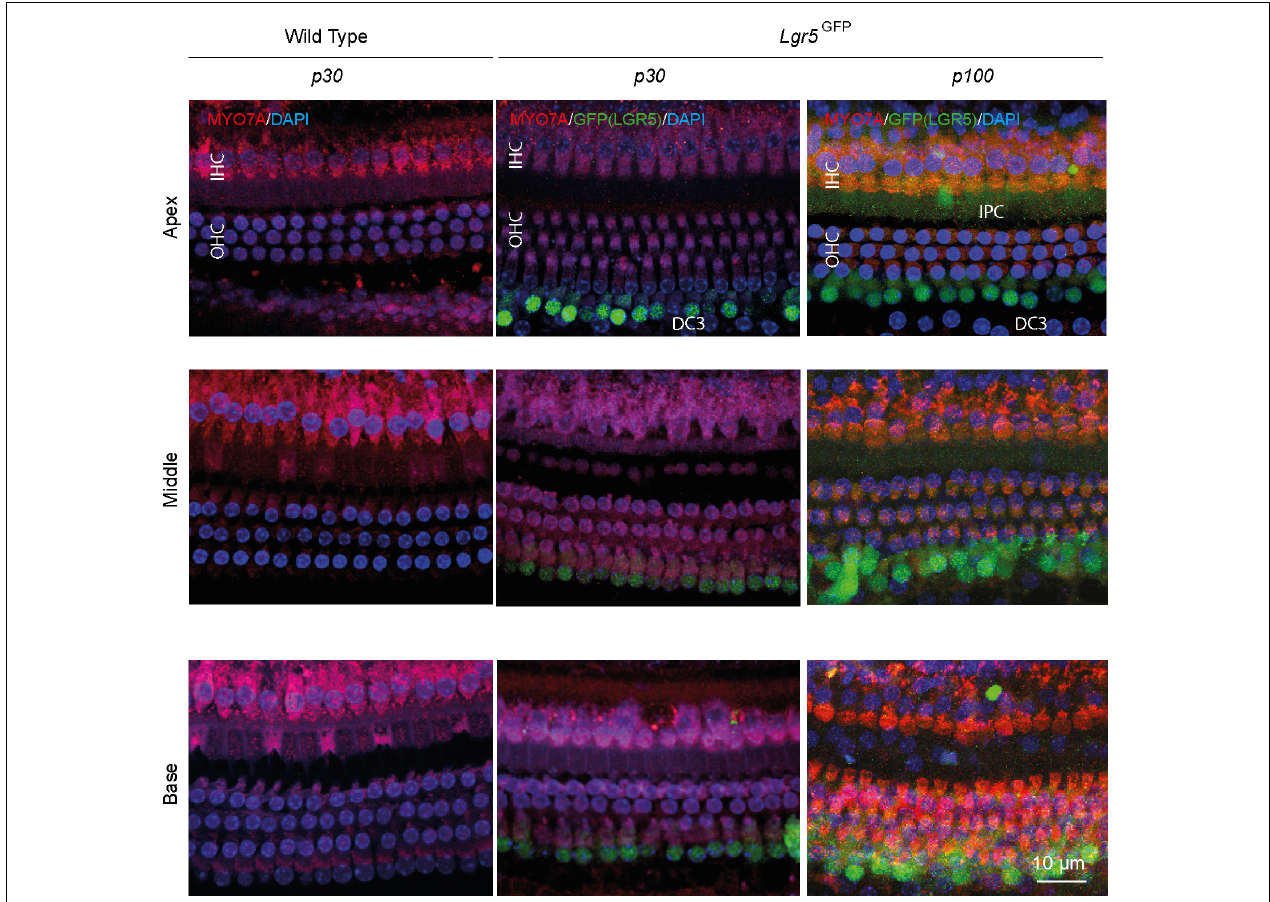
FIGURE 1 | Anatomy of the organ of Corti in normal-hearing wild type (WT) and Lgr5 GFP adult mice. Representative images of immunofluorescence microscopy of apex, middle and base in whole mount dissections of the cochlea of WT and Lgr5 GFP adult (p30 and p100) mice stained with myosin VII A (MYO7A) in red, GFP (LGR5) in green and DAPI in blue. GFP (LGR5) was detected particularly in the 3rd row of Deiters’ cells (DC3s) and, to a lesser extent, in the inner pillar cells (IPCs). No changes in GFP (LGR5) expression were found between p30 and p100 mice. Bar = 10 µ m. n WT = 3; n Lgr5 G FP ( p 30 ) = 7; n Lgr5 G FP ( p100 ) = 3 (representative images of 1 cochlea per